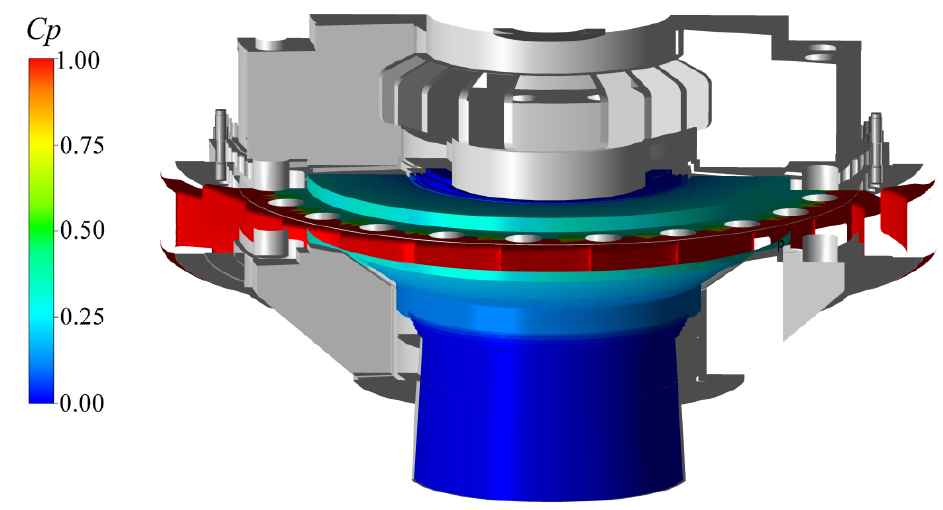
Figure 14. The mapped pressure distribution on the structural components (8.8 s).